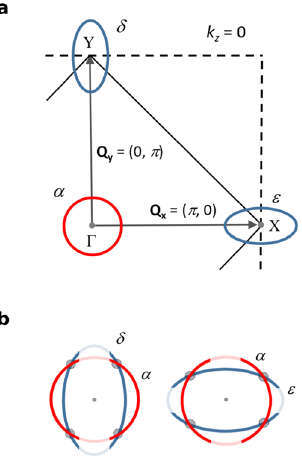
Fig. 4 Decoupling of the nematic and magnetic interactions and the Fermi surface of FeSe 1- x S x . a Schematic Fermi surface of FeSe 1- x S x outside of the nematic phase showing the Γ -centered hole pocket ( α ) and X, Y-centered electron pockets ( ε and δ ) at k z = 0. States on different pockets can be connected via fi nite- Q scattering as indicated by the gray arrows. b Schematic illustrating the distinct regions of quasiparticle dressing due to critical magnetic fl uctuations (grey circles) arising from the translation of the pockets through Q = ( π , 0), (0, π ), and nematic (Pomeranchuk) fl uctuations (lighter shaded regions on the electron/hole pockets where the quasiparticle spectral weight is reduced 63